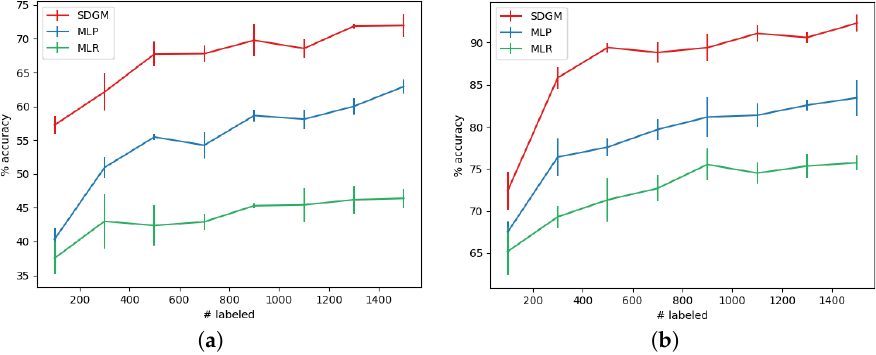
Figure 5. Comparison between the supervised MLP, MLR, and the semi-supervised SDGM trained on an increasing amount of randomly sampled and evenly distributed labeled data points. For each number of labeled data points, we trained 10 different models, since a large variance between the quality of the subsampled labeled data points may have existed. ( a ) The accuracy with one standard deviation for models trained on the simple input distribution {I, V}, and ( b ) the accuracy for models trained on the complex input distribution, {I, V, G, TExt, TMod, W}.